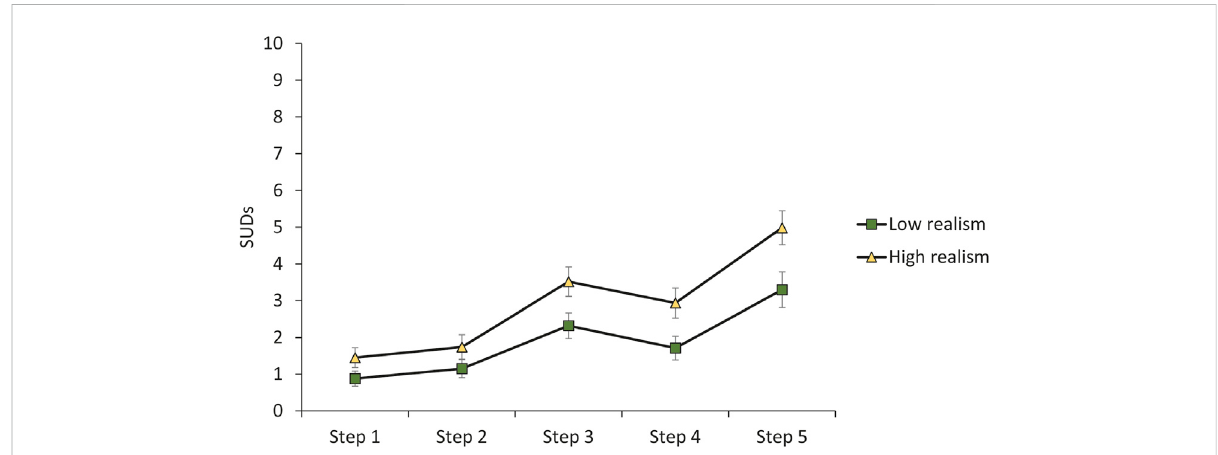
FIGURE 4 Self-reportedsubjectiveunits ofdistress(SUDs)ineachofthestepsoftheBATintheHoloLens2condition, dependingonexperienced realism. The groups were created through a median split (low realism, N = 34; high realism; N = 31) (error bars represent the standard error of the